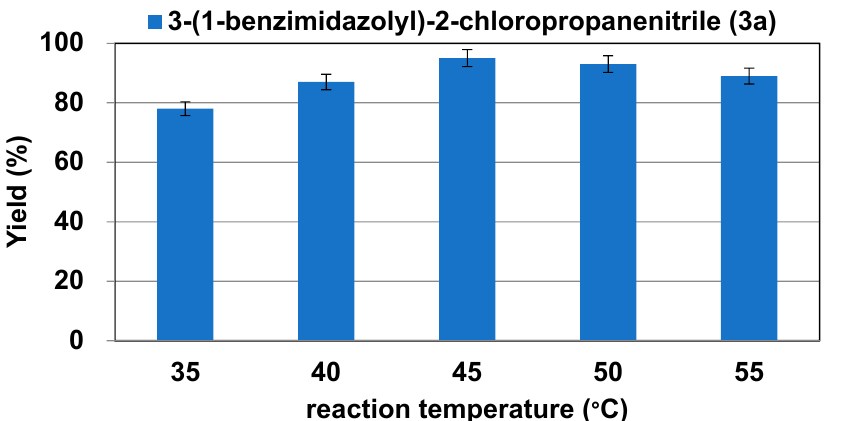
Figure 2. The influence of substrate ratio (benzimidazoles: α , β -unsaturated compounds) on the synthesis of N-substituted benzimidazole derivatives catalyzed by lipase TL IM from Thermomyces lanuginosus in continuous-flow microreactors.